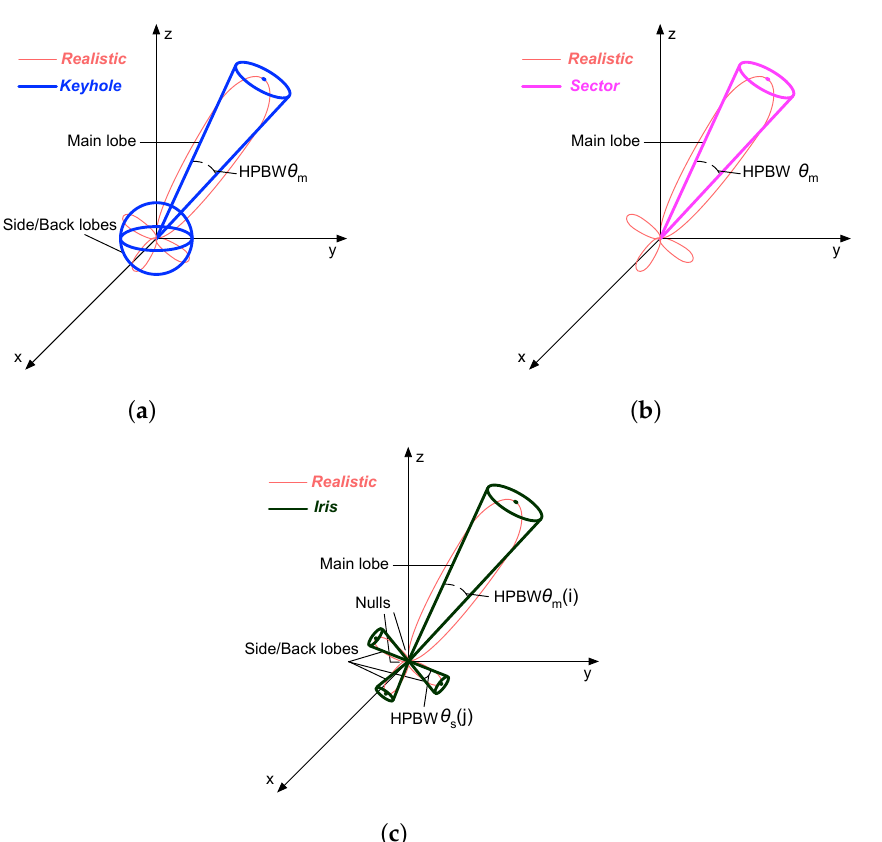
Figure 6. Directional antenna models. ( a ) Realistic vs. keyhole; ( b ) Realistic vs. sector; ( c ) Realistic vs.